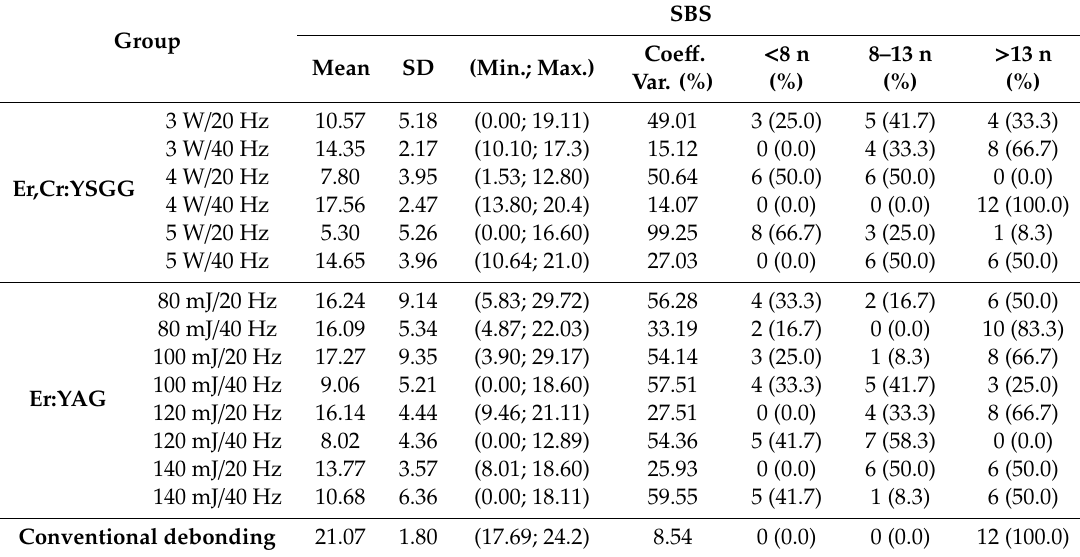
Table 4. Descriptive statistics for shear bond strength (SBS; n = 180). SD—standard